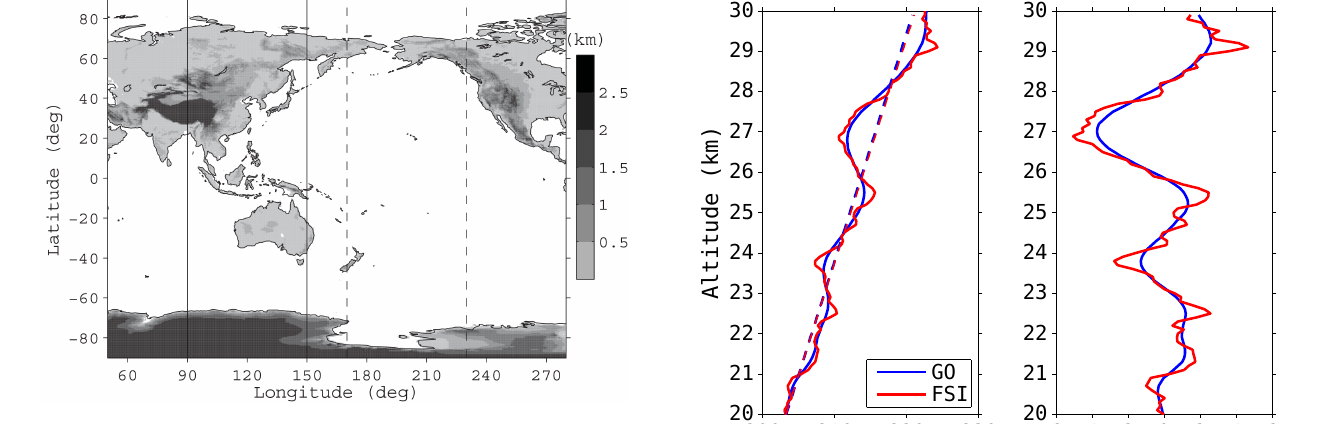
Figure 1. Global topography map with a 0.25 ◦ × 0.25 ◦ resolution taken from National Geophysical Data Center (www.ngdc.noaa.